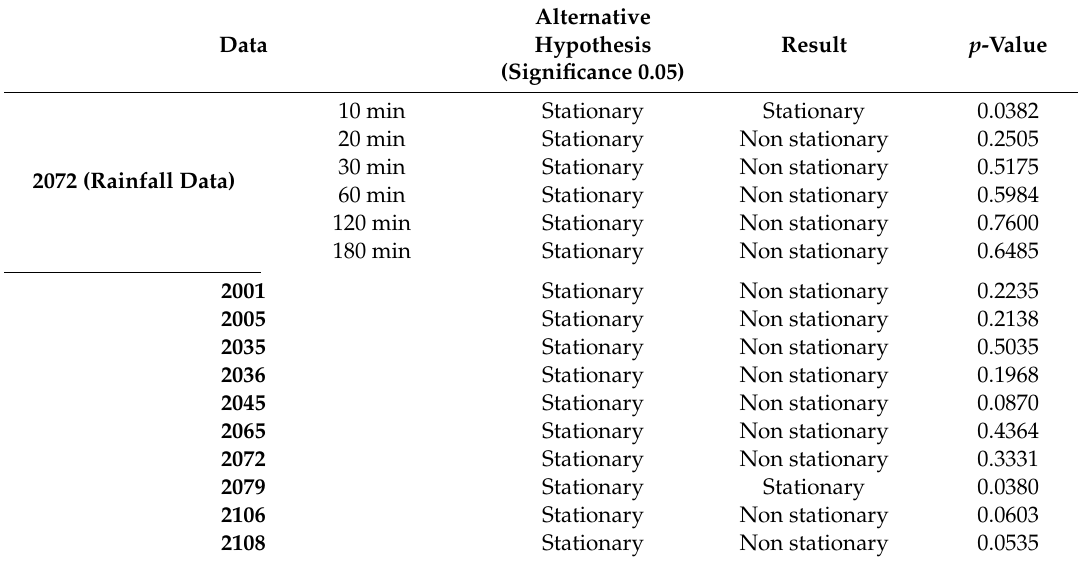
Table 3. Augmented Dickey–Fuller hypothesis test for precipitation data from stations used in the study